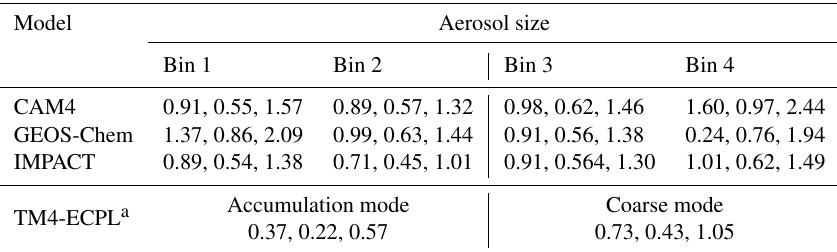
Table 3. Global mean bias correction factors (median, lower 95% confidence interval and upper 95% confidence interval) derived for each model and each aerosol size (bins or modes) based on state-of-the-art constraints on size-resolved dust loading (Kok et al., 2017), taken into account for the ensemble model